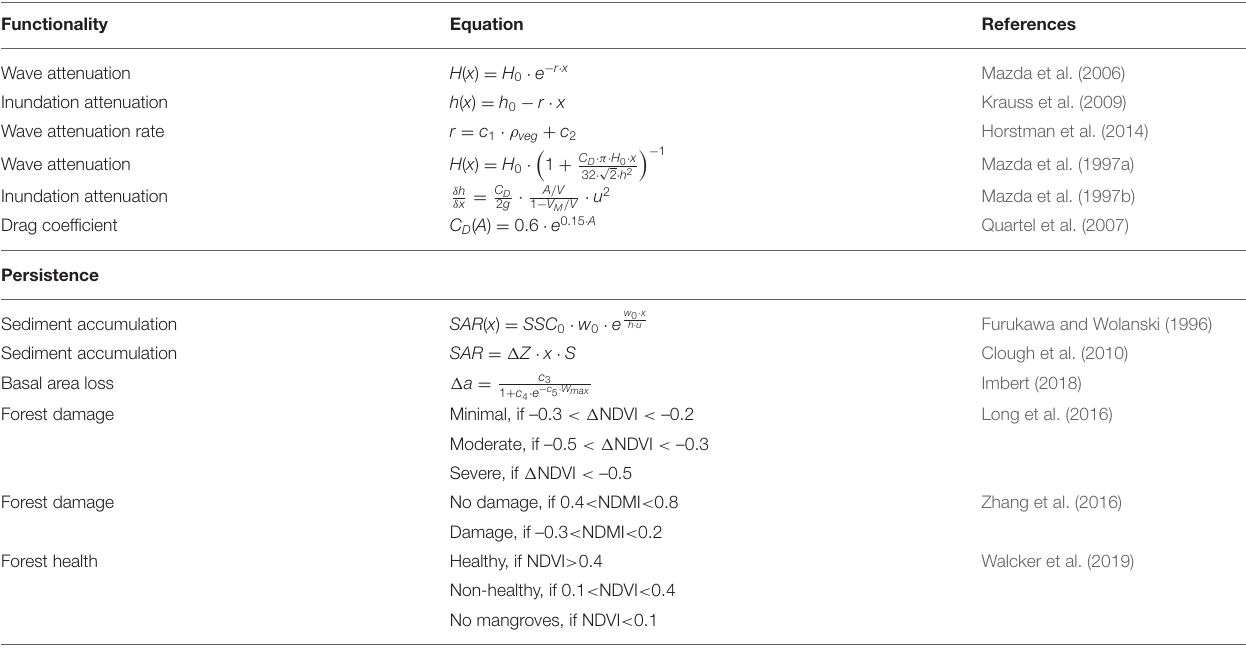
TABLE 2 | Existing empirical models for preliminary quantitative assessments of mangrove functionality and